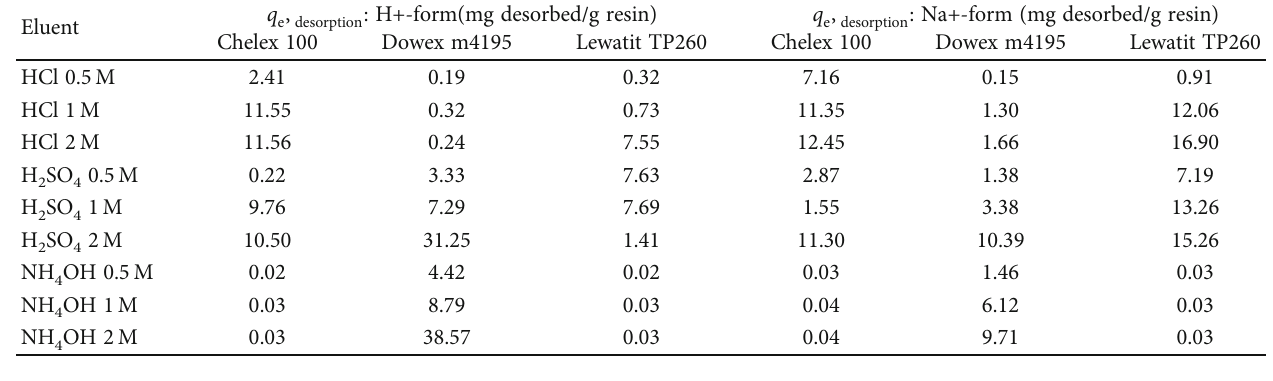
Table 4: Desorption capacity of copper (II) ions onto three chelating resins with various eluent concentrations. , q desorption : H+-form(mg desorbed/g resin) e Eluent